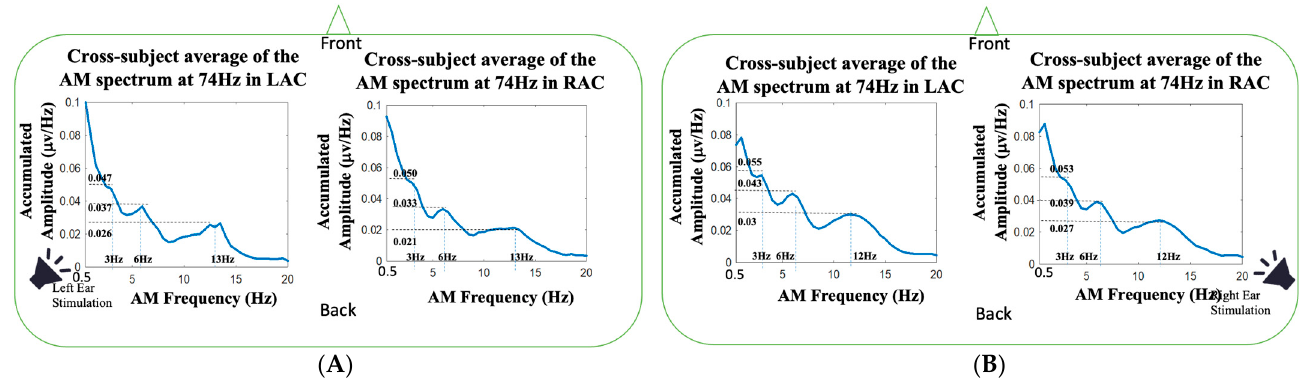
Figure 5. The AM spectra of the 37 Hz FM frequency averaged across the twenty-five subjects in our study: ( A ) the cross-subject average of the AM spectrum at 37 Hz in LAC and RAC during left-ear auditory stimulations; ( B ) the cross-subject average of the AM spectrum at 37 Hz in LAC and RAC during right-ear auditory stimulations.